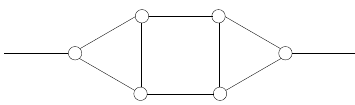
) with two reducible triangles that cannot be reduced at Figure 3: A subgraph ext ( K − 4